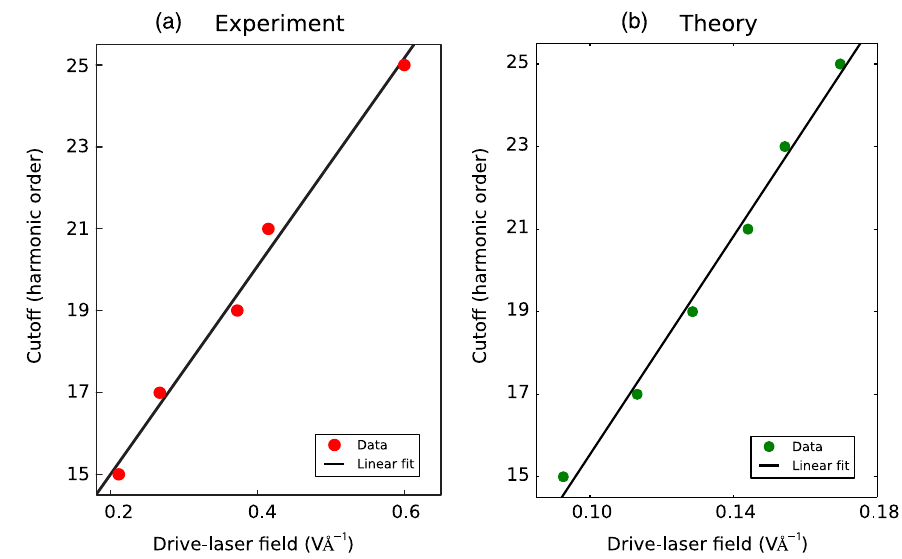
FIG. 6. Experimental and theoretical comparison: Linear scaling of the cutoff harmonic order with the laser electric-field strength as obtained in (a) the experiment [courtesy of Louis DiMauro from Fig. 1(b) of Ref. [5] and (b) theoretical calculations by means of the Wannier-Bloch